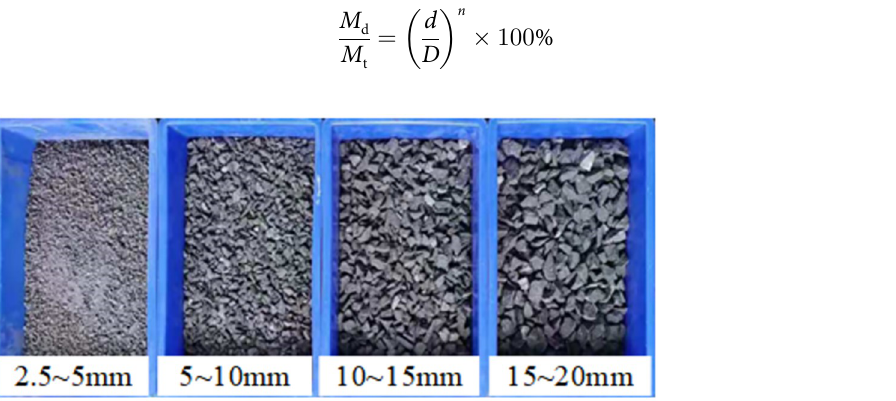
Fig 2. Coal gangue particles of various